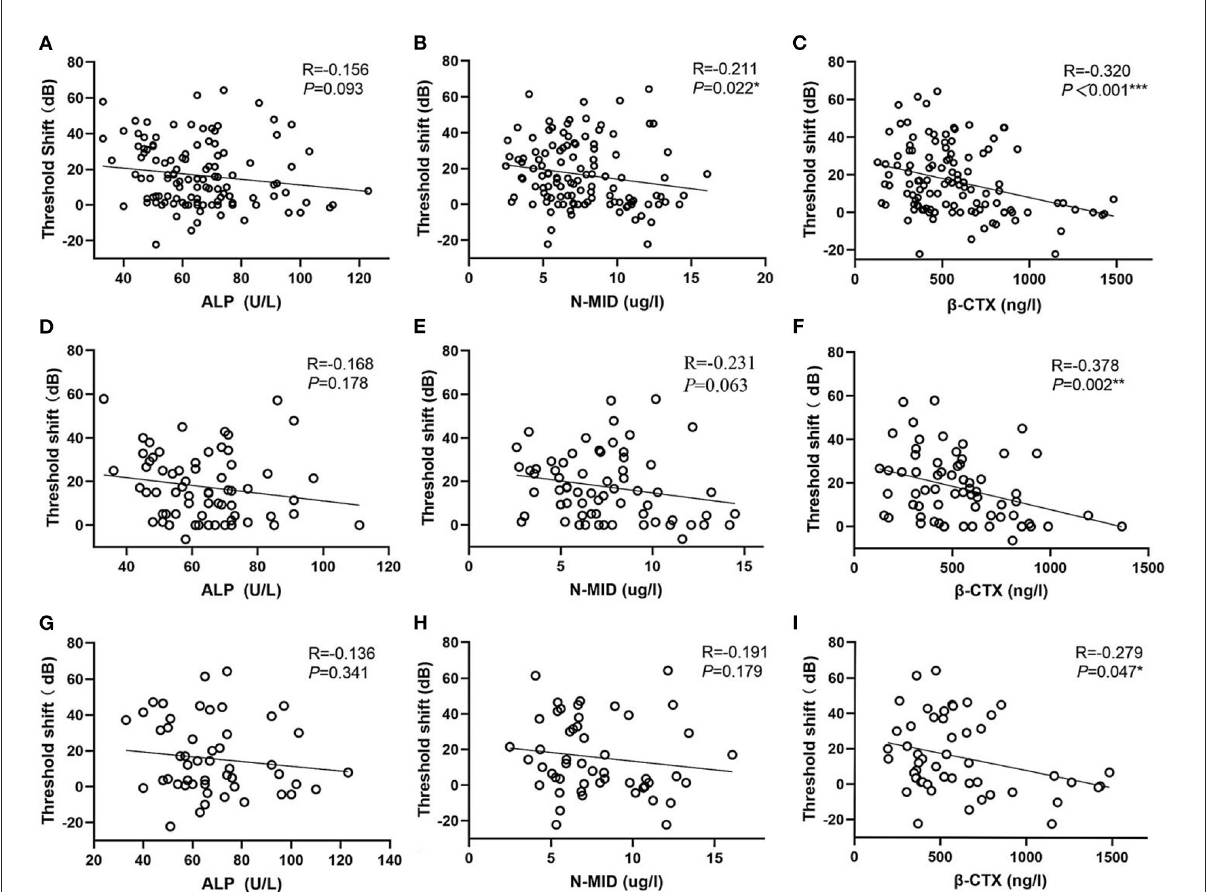
FIGURE5 Scatter plots. (A–C) Represent the relationship of ALP, N-MID and β -CTX vs. the threshold shift, respectively. (D–F) Represent the relationship of ALP, N-MID and β -CTX vs. the threshold shift in women SSNHL, respectively. (G–I) Represent the relationship of ALP, N-MID and β -CTX vs.